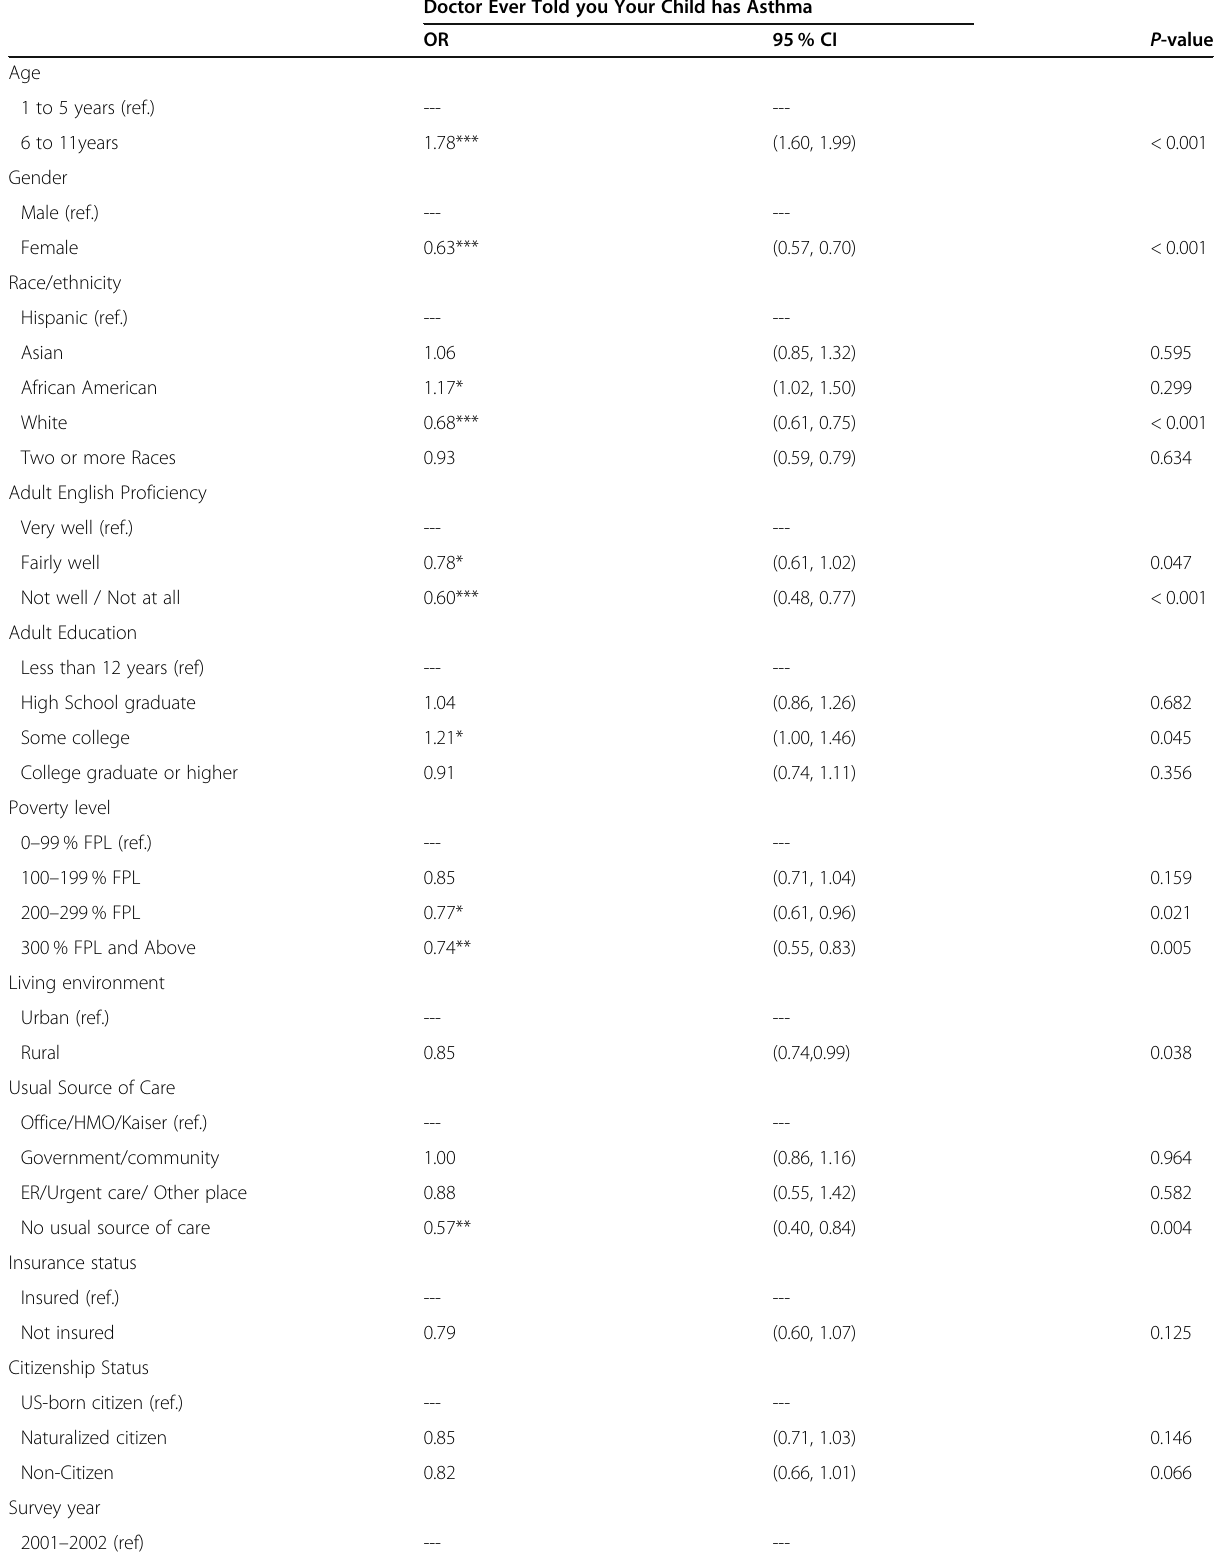
Table 2 Logistic Regression for asthma diagnosis ( n =